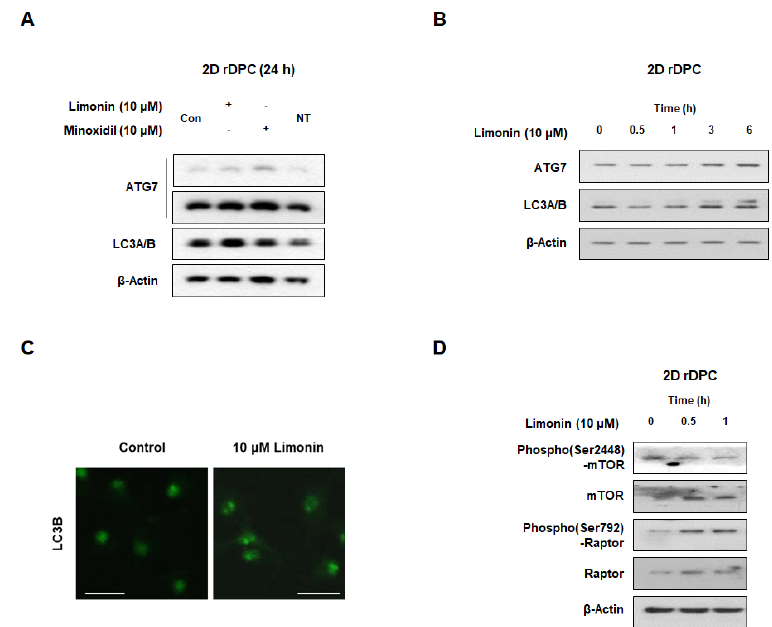
Figure 2. Limonin activates autophagy pathways in two-dimensional cultured rDPC. ( A ) Representative images of Western blot for autophagy-related proteins ATG7 and LC3A/B after treatment with limonin and minoxidil (positive control) for 24 h. ( B ) Representative images of Western blots for ATG7 and LC3A/B after treatment with limonin for 0–6 h. ( C ) Confocal microscopy images for changes in the number of LC3B puncta after treatment with limonin for 24 h. ( D ) Representative images of Western blots for upstream regulators of autophagy, phospho(Ser2448)-mTOR and phospho(Ser792)-Raptor, after treatment with limonin for 0, 0.5, and 1 h. Scale bars, 50 μ m. Con, vehicle-treated control; NT, not-treated.